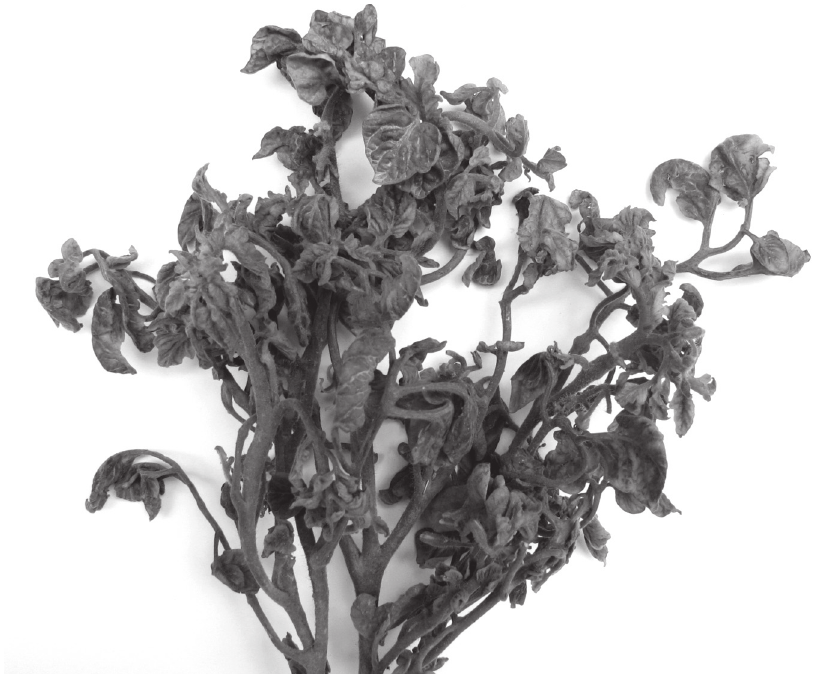
Figure 1. Symptoms produced by TYLCV in a naturally infected tomato